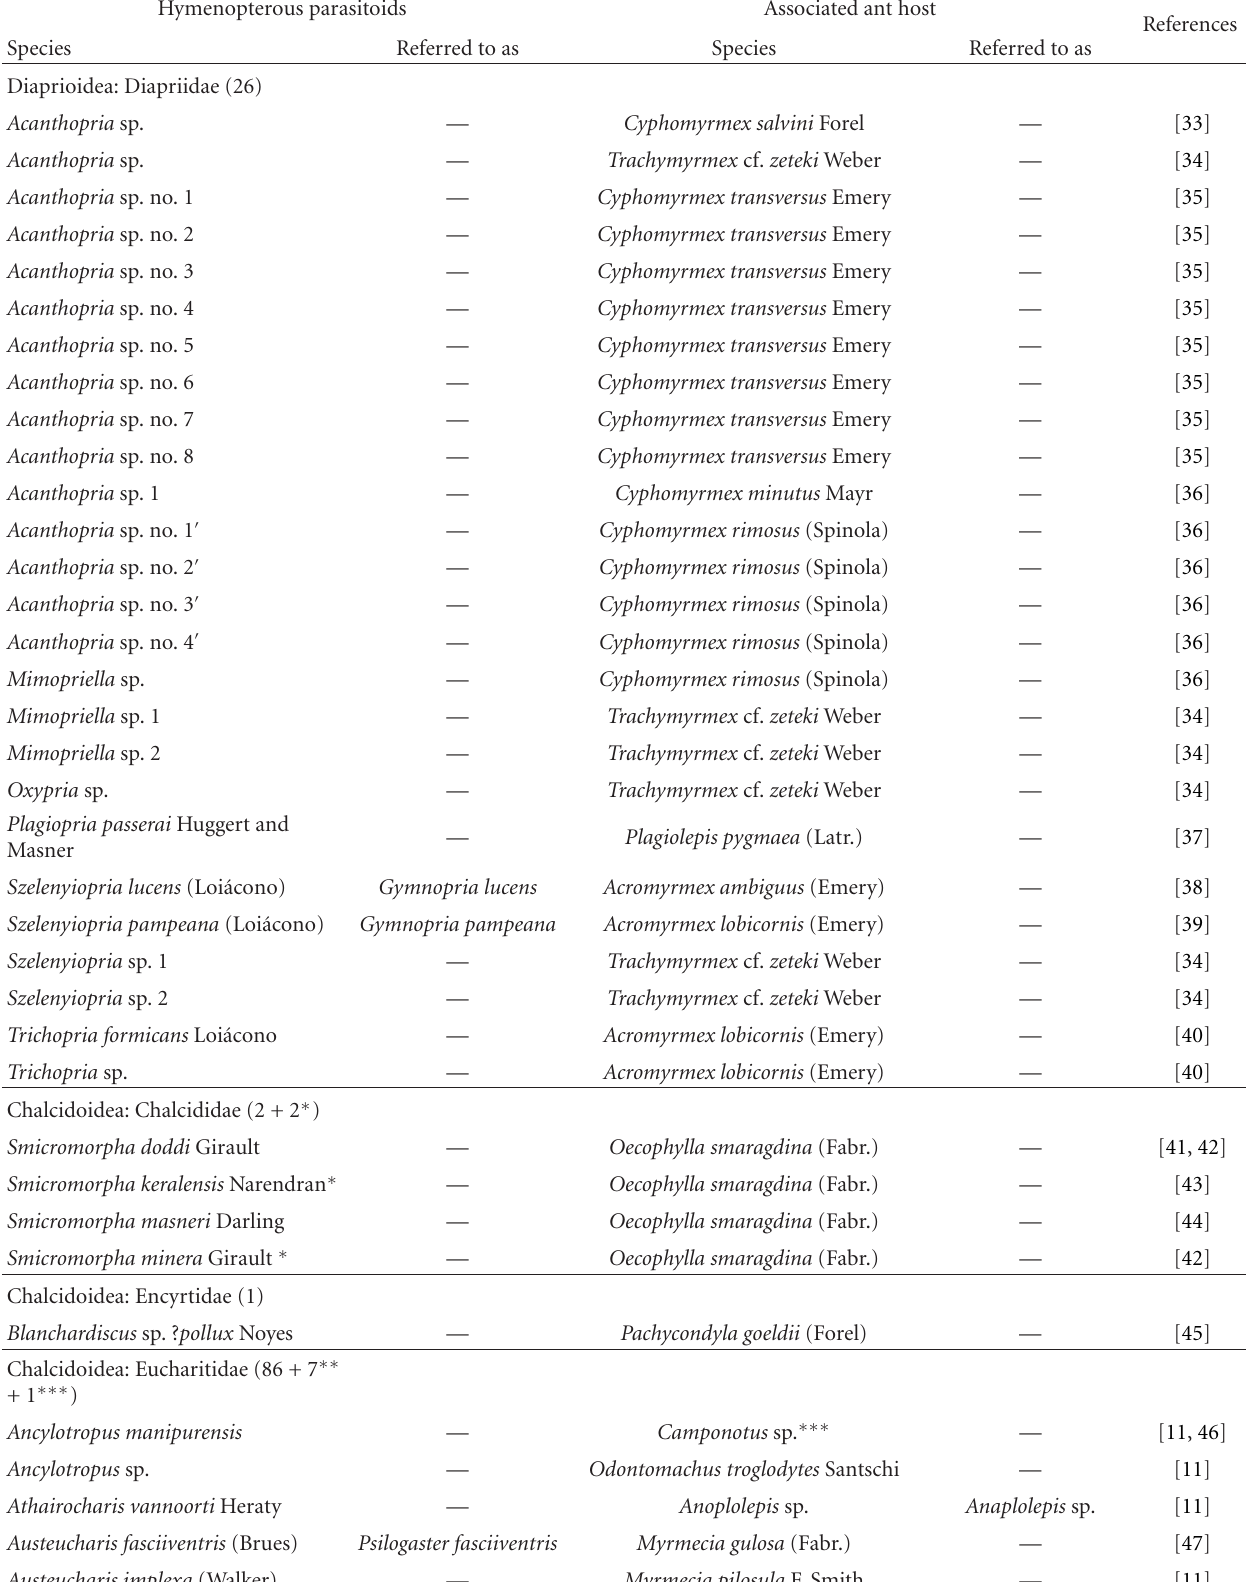
Table 1: List of parasitic wasps recorded as true primary parasitoids of ants (brood or adult). As all of the eucharitids are true parasitoids of ants, all known associations with ants have been included, but see ∗∗ . For further details, see